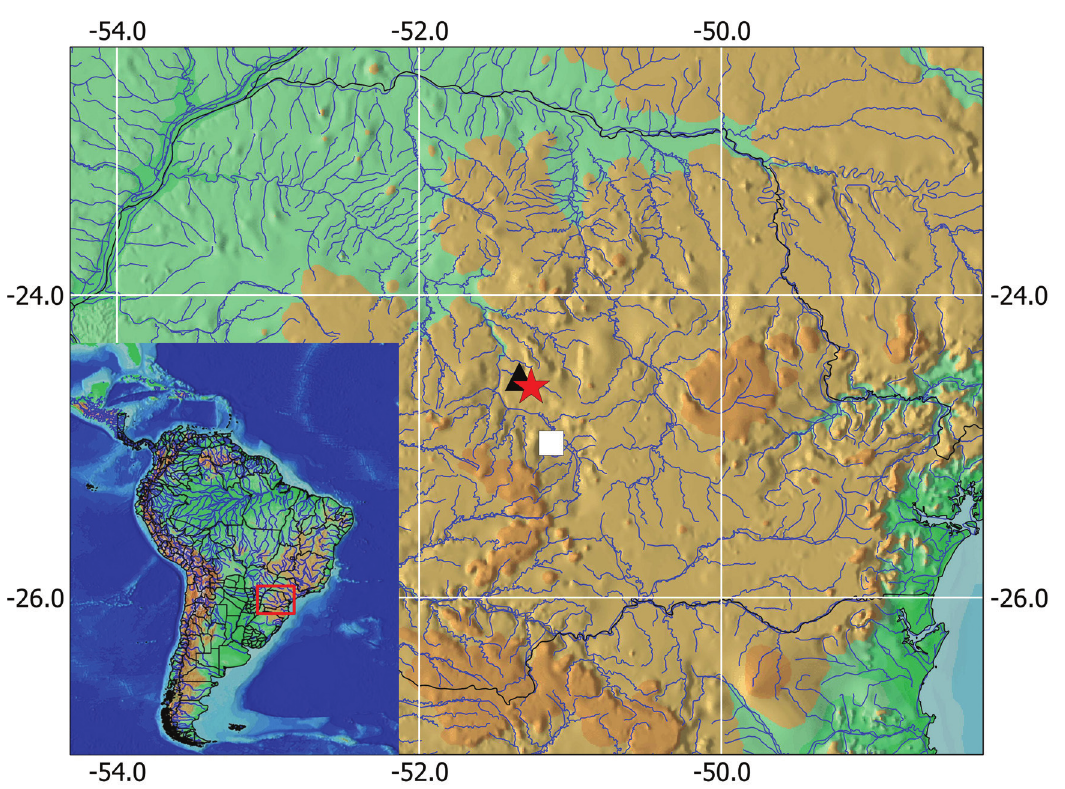
Fig. 3. Map showing geographic distribution of Corydoras lacrimostigmata . Red star represents the type locality, rio Maria Flora, the triangle represents rio Nestor and the square represents rio Barra Grande, upper rio Paraná basin, Paraná. Each symbol may represent more than one